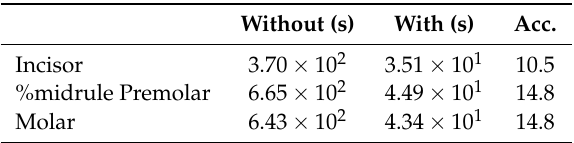
Table 1. This shows the averaging stitching time in seconds with/without using the gyro information for the incisor, premolar, and molar